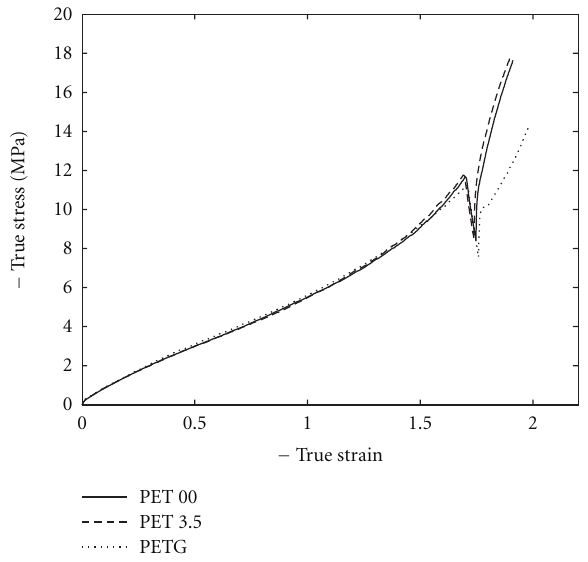
Figure 9: Material comparison, uniaxial compression at 90 ◦ C and 0.1/s, and hold at − 1.7.